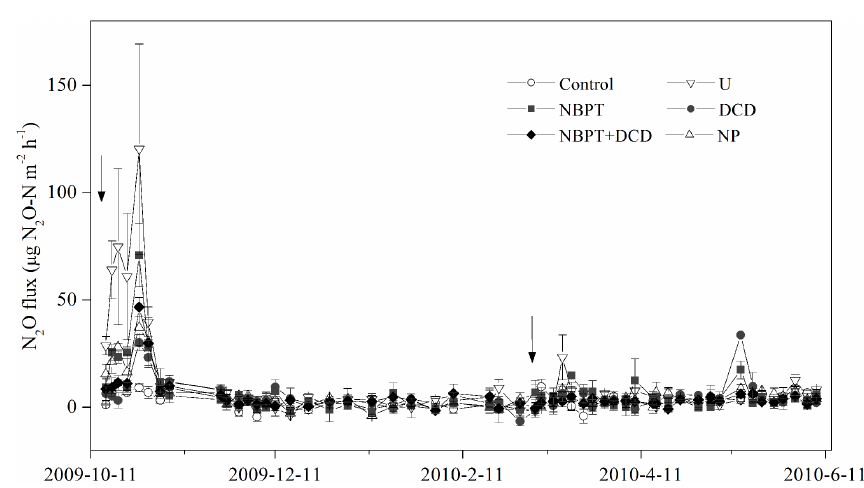
Figure 2. Temporal variation of nitrous oxide fluxes in the control, urea alone (U), urea with NBPT (NBPT), urea with DCD (DCD), urea with NBPT plus DCD (NBPT plus DCD) and nitrophosphate (NP) treatments during the wheat growth season. Flux values are mean values ± standard errors for three replicates. Arrows indicate date of fertilizer application. Table 3. Correlation between ln [ N 2 O flux + 1 ] and soil WFPS, soil temperature at depths of 5 ( T 5cm ), 10 ( T 10cm ) and 15cm ( T 15cm